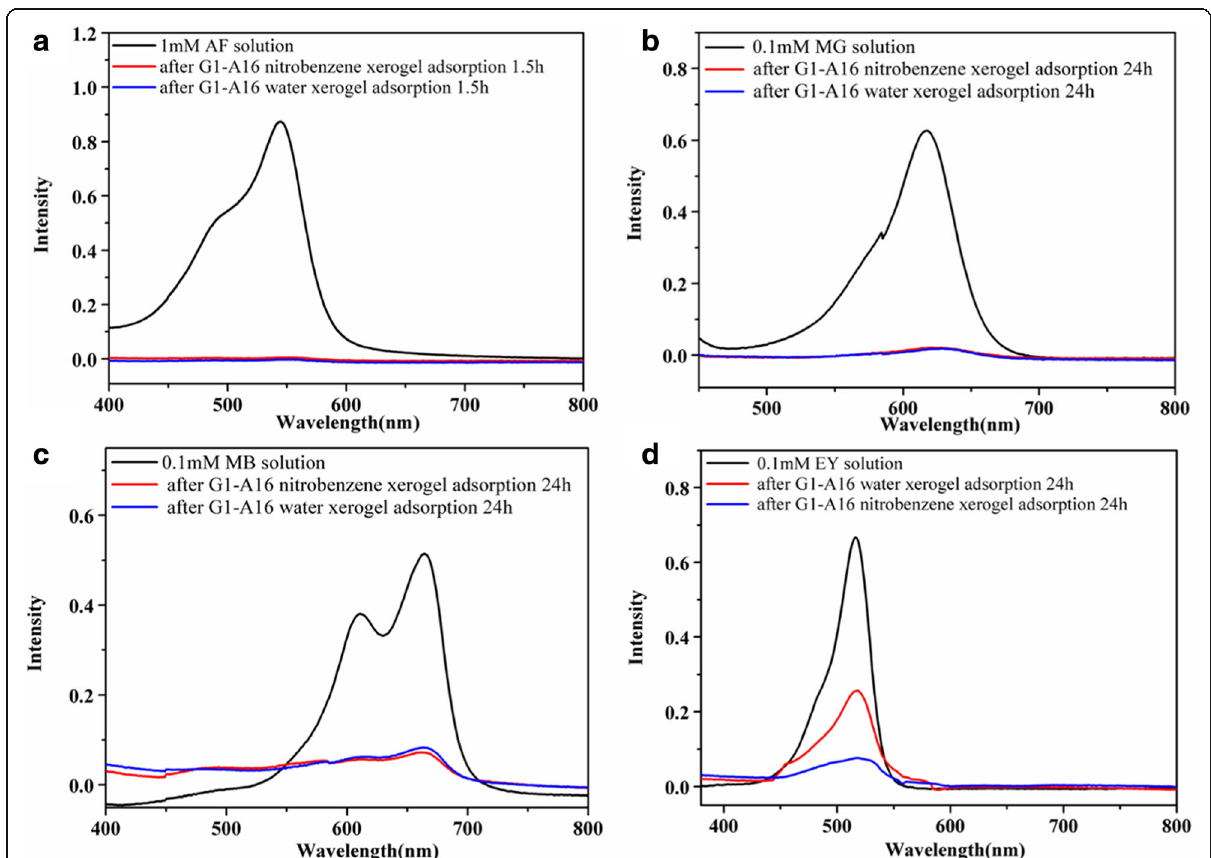
Fig. 4 UV – vis spectra of the dye solutions before and after removal over the G1-A16 xerogels: a AF, b MG, c MB, and d